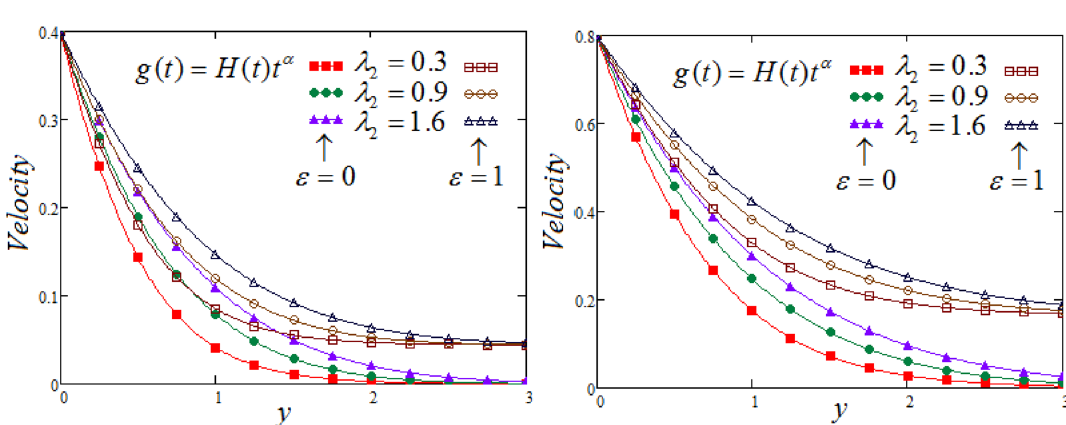
Figure 6. Representation of fluid velocity v ( y , t ) against y for distinct values of (cid:31) 1 with N = 2.5, Pr eff = 4.5, R